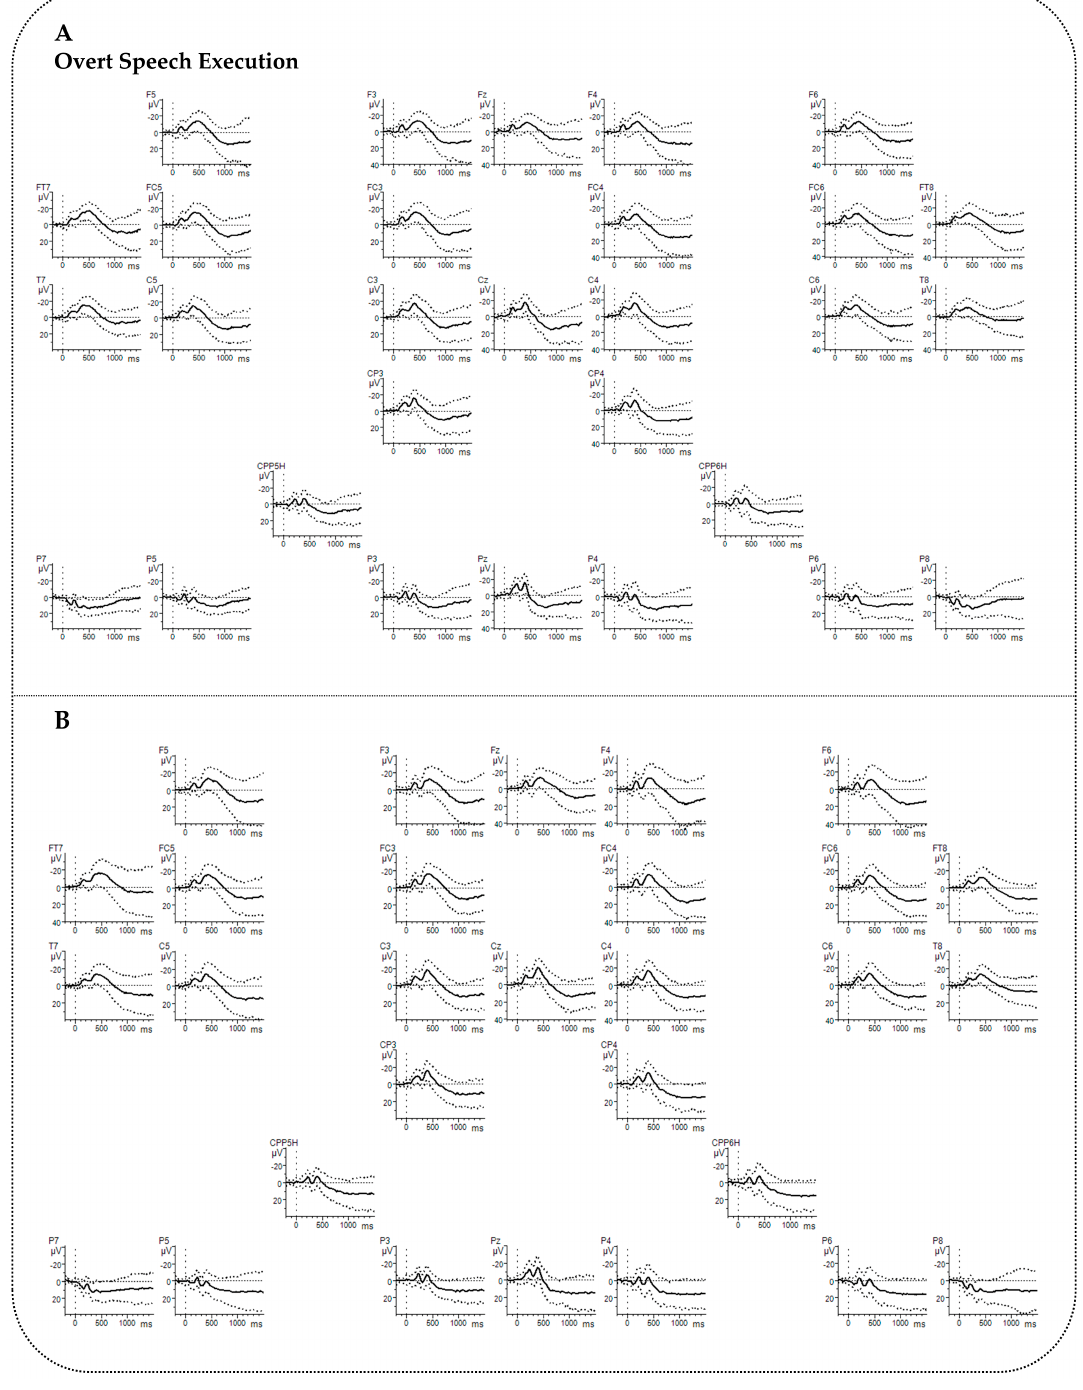
Figure A6. Event-related brain potentials (ERP) for the Execution phase including standard deviations. ( A ) Grand averages for the Overt Speech Execution ( B ) Grand averages for the Inner Speech Execution. Negative polarity is plotted upward. The x-axis ranges from − 200 to 1500 ms. No low-pass filter was applied for presentation